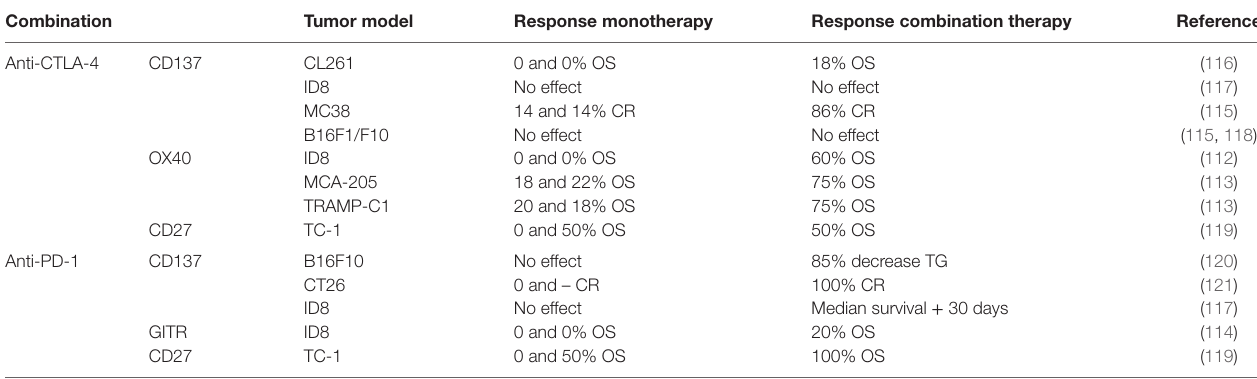
TABLe 2 | Preclinical studies immune-checkpoint blockade plus co-stimulation.